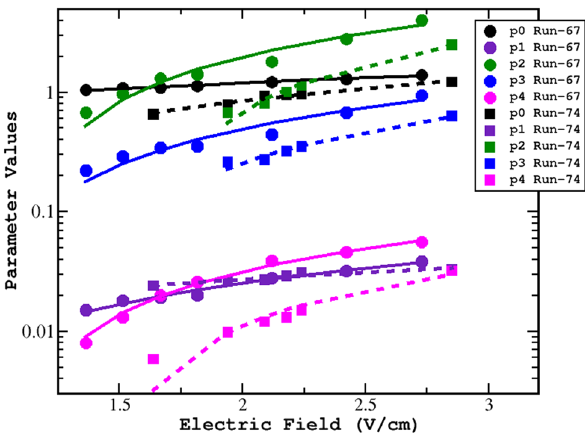
Fig. 8 Shown are the fitting parameters, p 0 to p 4 from Eq. (1) as a function of the applied field, E , and fits a linear regres- sion model, which demonstrates the correlation of the parameters with the electric field using data from each run. The fitting func- tions for those parameters in Run 67 (solid lines fitted to the circles) are: p 0 =0.25 E +0.69, p 1 =0.017 E − 0.0087, p 2 =2.27 E −